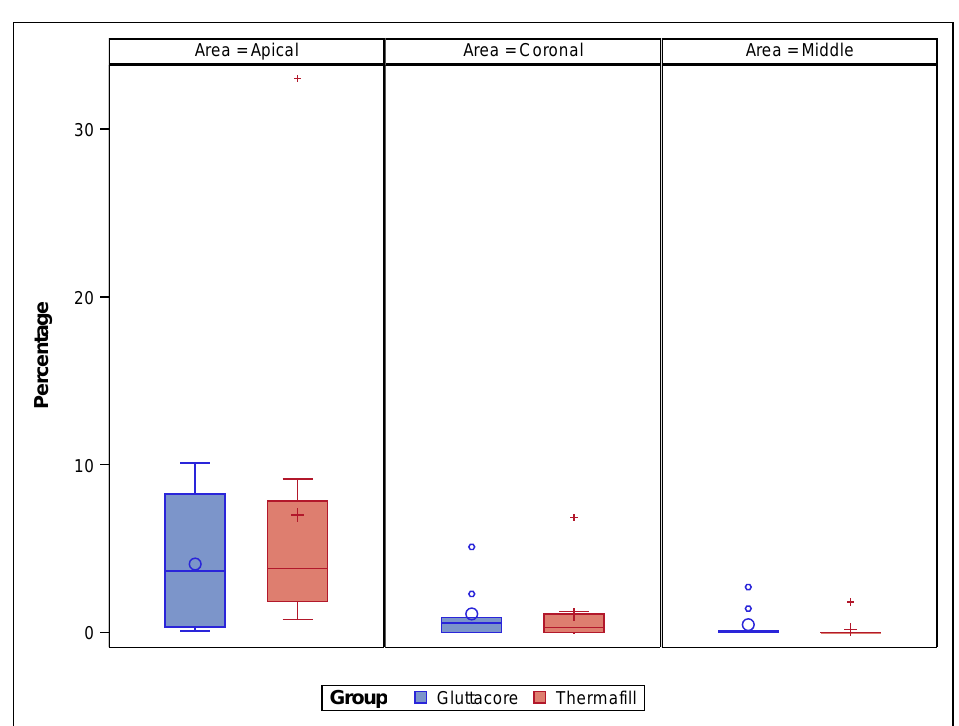
Figure 5. Box plot of the proportion (%) between the volume of the root canal system and the remaining carrier-based root canal filling material from the coronal, middle and apical thirds of the straight root canal systems.